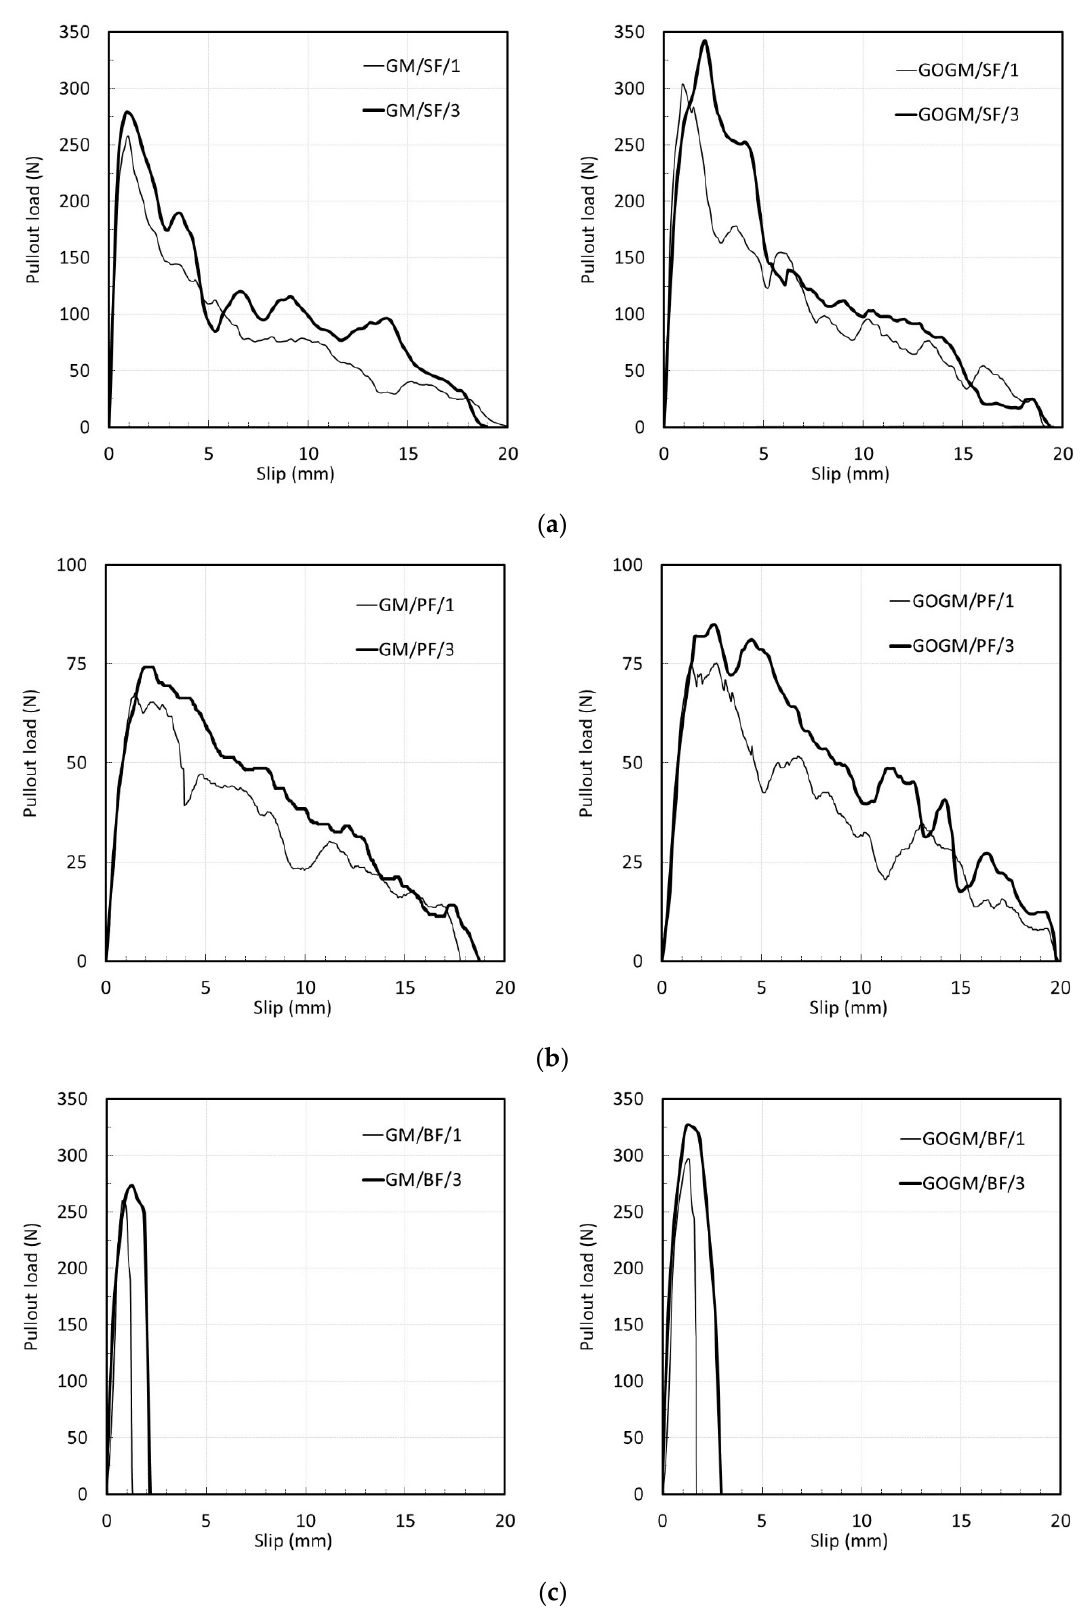
Figure 7. Effect of loading rate on bond-slip responses of: ( a ) SF, ( b ) PF, and ( c ) BF. In the case of GOGM, increases of about 12.7, 12.9, and 10.2% were observed for GOGM/SF, GOGM/PF, and GOGM/BF, respectively. The GOGM appears to be more sen- sitive to loading rate than GM, as seen by the higher increasing percentage. This contrib- utes mainly to the higher compressive strength of GOGM due to the addition of GO. Kim et al. [67] similarly reported the increase in rate sensitivity of fiber embedded in cement material with higher compressive strength. 3.3.3. Mechanical Properties The results of peak pullout load, strength, and bond strength are given in Tables 7 and 8, and the pullout energy (toughness) is shown in Figure 8. Both peak pullout stress and bond strength in GOGM (SF/GOGM, PF/GOGM, and BF/GOGM) were higher than in GM (SF/GM, PF/GM, and BF/GM). They were increased by 11–17% for a loading rate of 1 mm/s and 14–23% for a loading rate of 3 mm/s. Figure 8. Pullout energy or toughness .